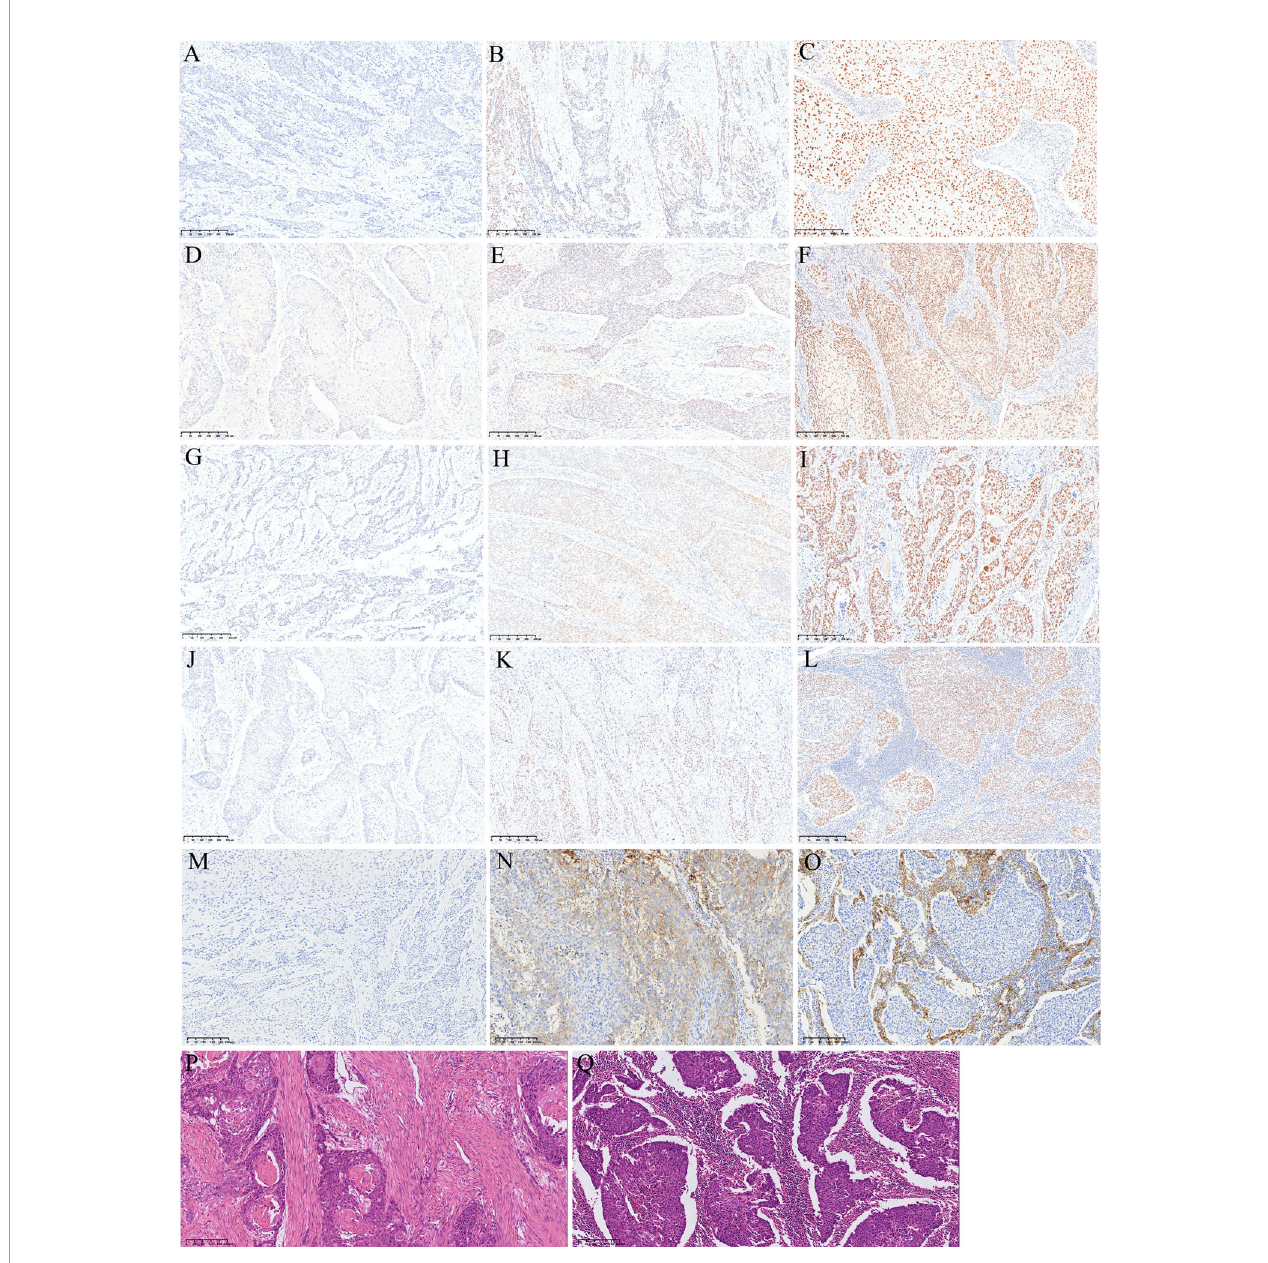
FIGURE 1 | Representative images of HE and IHC. (A) Loss of MLH1 protein expression; (B) low MLH1 protein expression; (C) high MLH1 protein expression; (D) loss of PMS2 protein expression; (E) low PMS2 protein expression; (F) high PMS2 protein expression; (G) loss of MSH2 protein expression; (H) low MSH2 protein expression; (I) high MSH2 protein expression; (J) loss of MSH6 protein expression; (K) low MSH6 protein expression; (L) high MSH6 protein expression; (M) negative PD-L1 expression; (N) positive PD-L1 expression in tumor cells; (O) positive PD-L1 expression in tumor associated immune cells; (P) low TILs; (Q) high